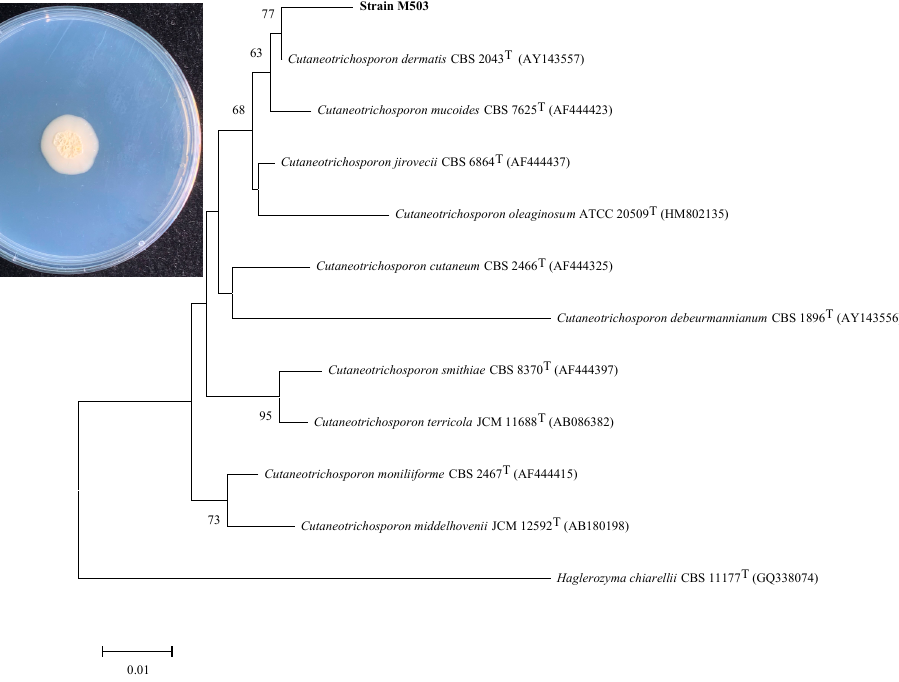
Figure 1. Strain M503 colony morphology on PDA at 30 °C for seven days. Phylogenetic tree on the basis of the ITS gene sequences (OM108212) of C. dermatis and other related strains. GenBank accession numbers are in parentheses.